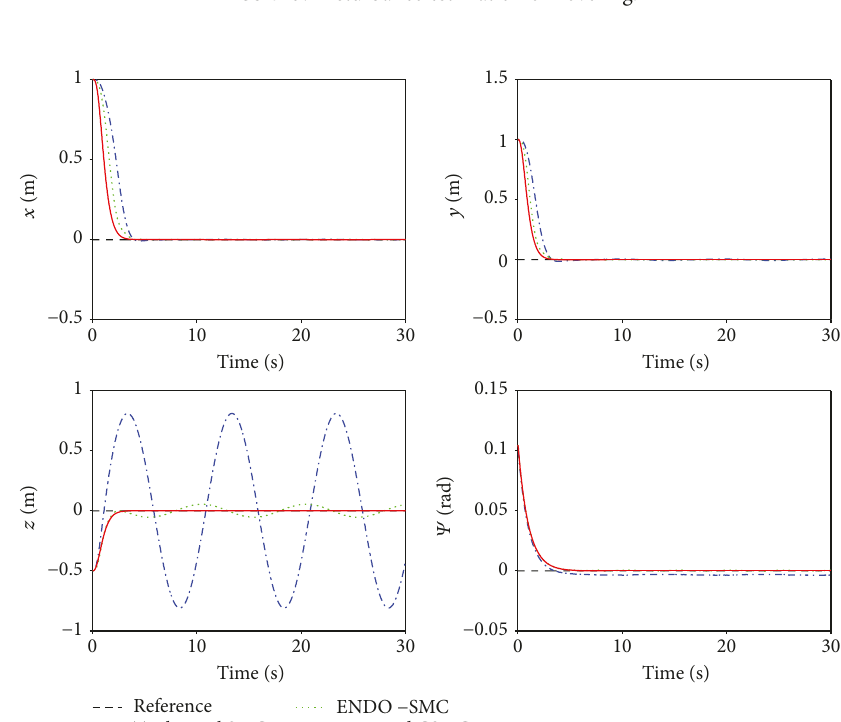
Figure 4: The response curves of position and yaw angle of hovering.